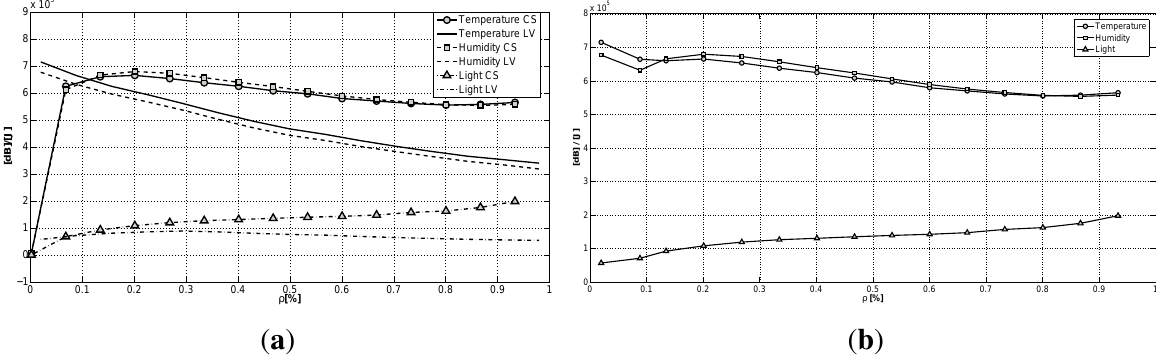
Figure 8. ( a ) Ratio between the recovery quality and energy spent in compression varying the sub-sampling factor ρ for the two approaches; ( b ) the combination of the two